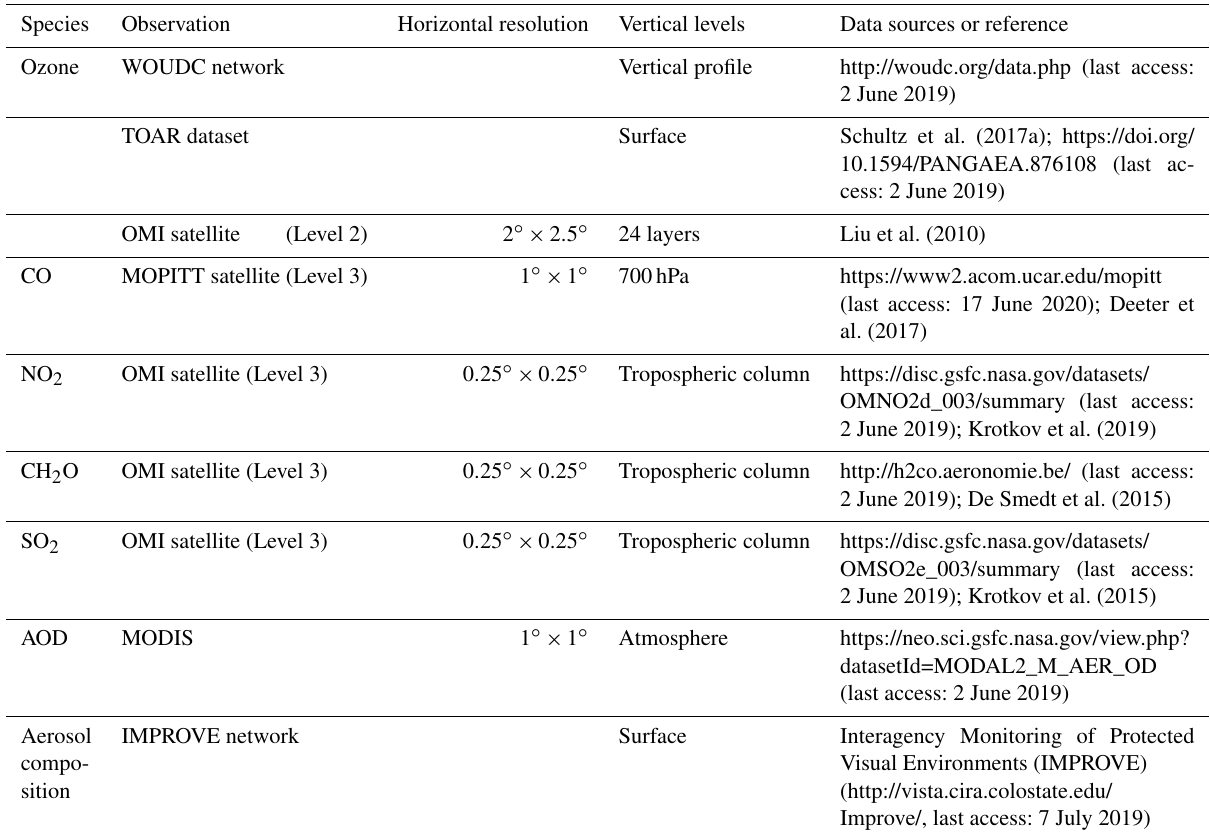
Table 3. Observational datasets used for model evaluation. Species Observation Horizontal resolution Vertical